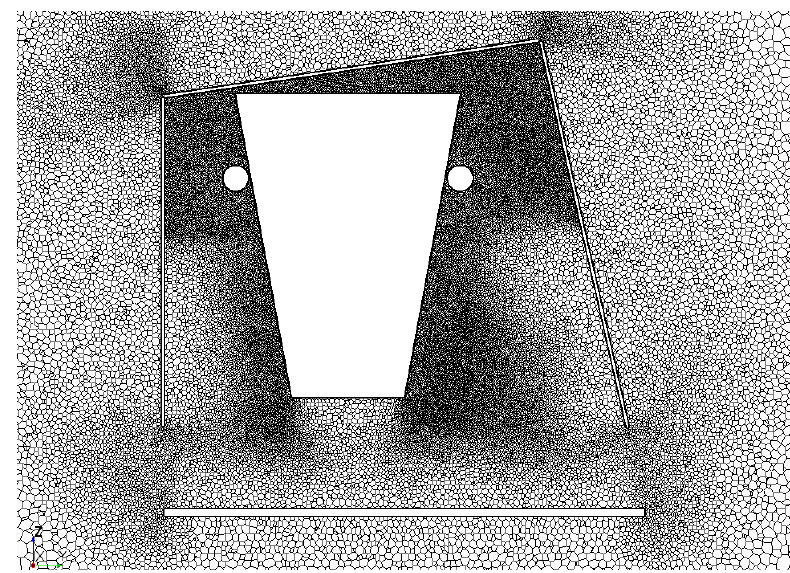
Figure 4. Computational grid in the central section plane in proximity to the enclosure. Note that only the part of the containment room in the vicinity of the enclosure is seen. The white areas belong to the solid domain and represent the engine block and the exhaust manifolds.